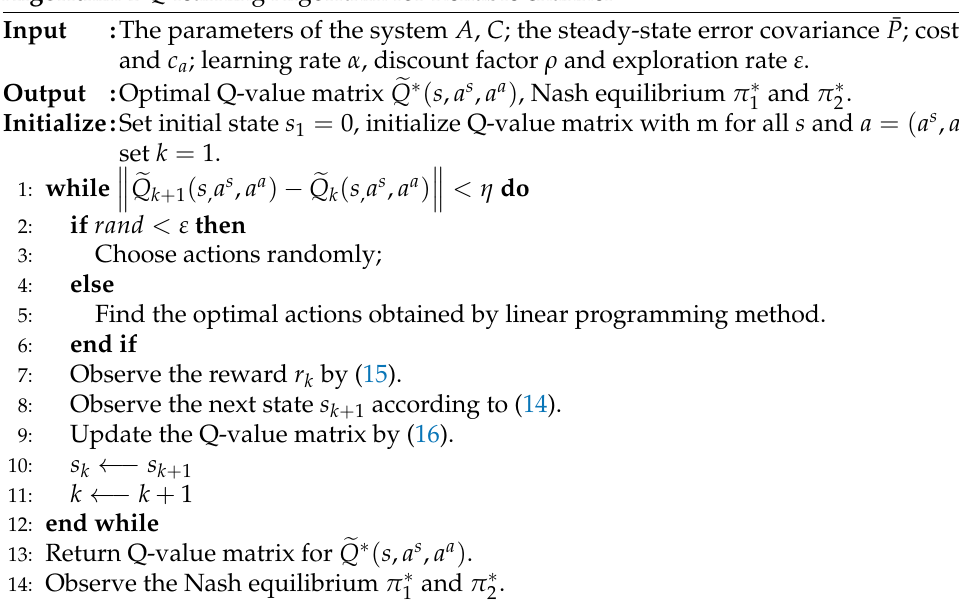
Algorithm 1 Q-learning Algorithm for Reliable